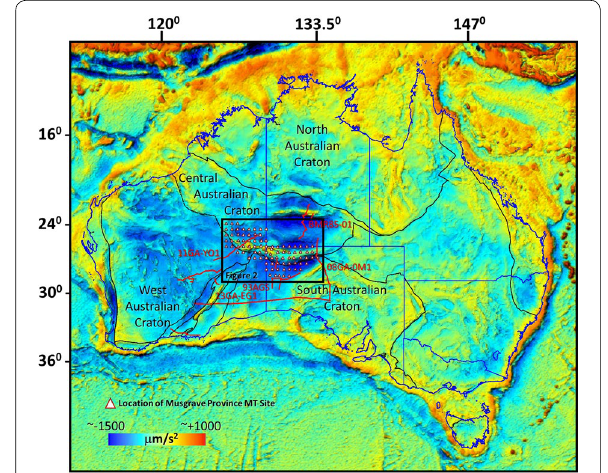
Fig. 1 Gravity image of Australia, showing the main crustal elements. The Musgrave Province is located on the boundary between the Central and South Australian Cratons. Low gravity regions are shown in blue and high gravity regions in red. The new Musgrave Province MT sites described in this study are shown as triangles. All regional deep seismic traverses intersecting the Musgrave Province are shown as red lines, with seismic line names provided for those traverses referred to later in the text. All MT profiles intersecting the Musgrave Province are coincident with deep seismic traverses. The region used for Fig. 2 is marked by the black bounding